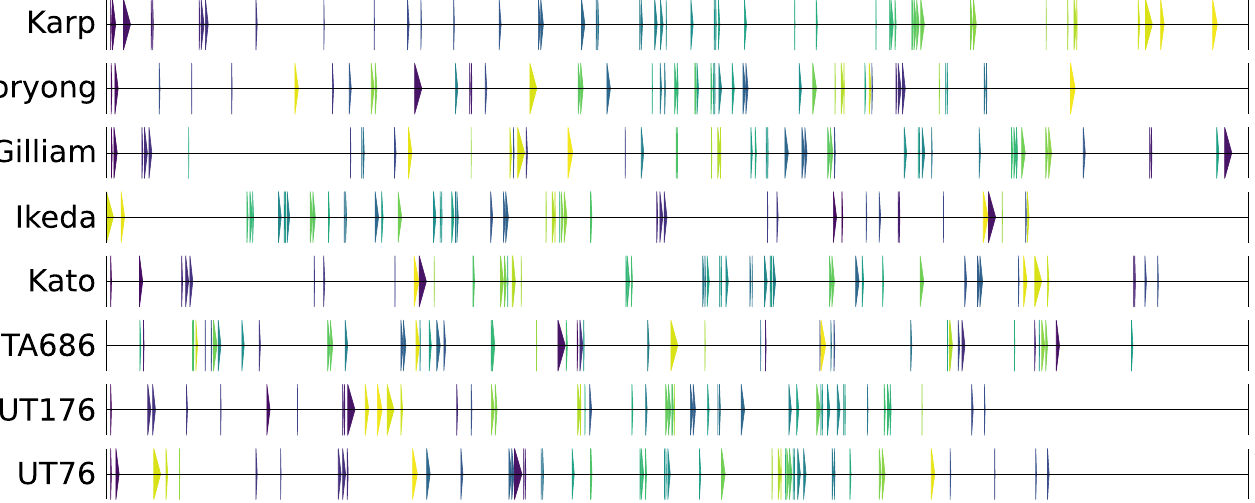
Fig 3. Each arrow represents the location of a core gene island containing one or more core genes which are conserved in the same order within an island across all strains. The arrows are coloured relative to their order in the Karp